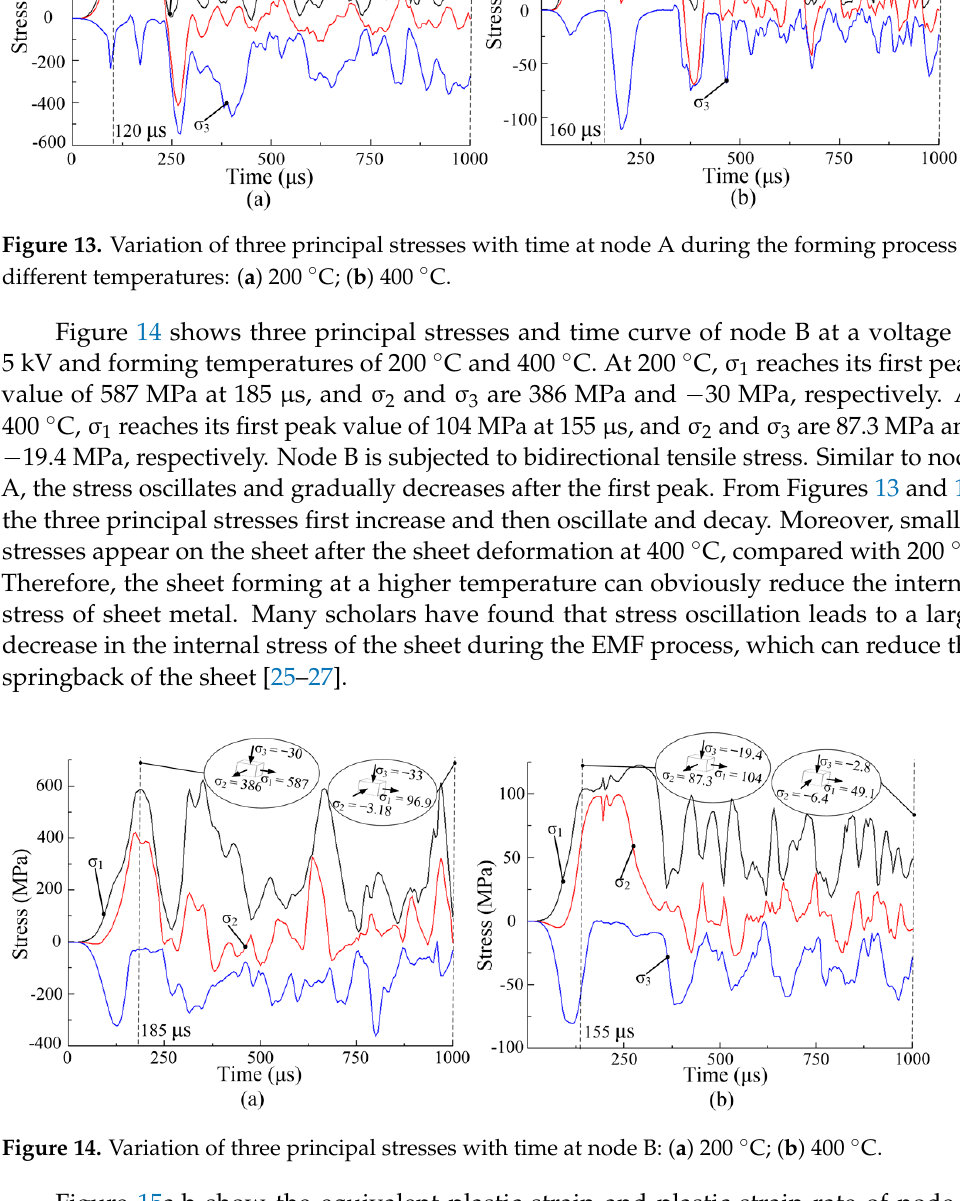
Figure 12. Equivalent plastic strain of sheet material at different time points during the forming process at different temperatures: ( a ) 200 °C; ( b ) 400 °C.